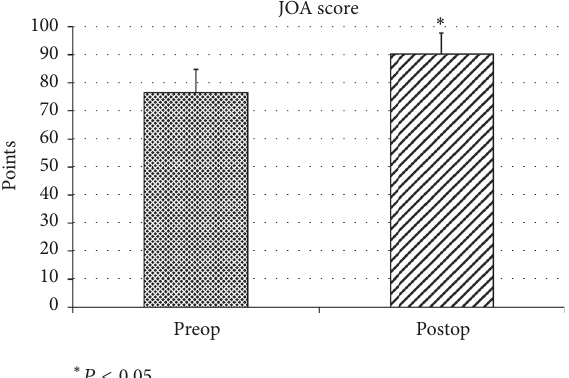
Figure 5: JOA score . At the last follow-up, the JOA score improved from the preoperative mean of 76.4 points to 90.2 points. There was significant difference between preoperative and last follow-up score in the JOA score ( 𝑃 < 0.01